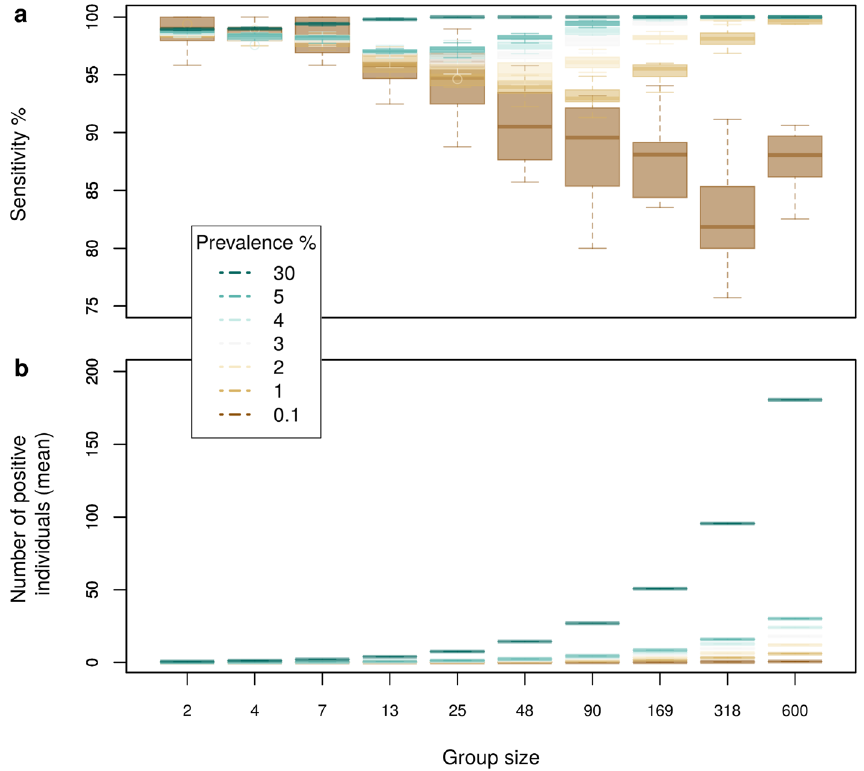
Figure 2. Effect of group size and prevalence on test sensitivity. Simulations were performed for seven prevalence scenarios and ten group sizes with 100 simulation iterations each. ( a ) The sensitivity of the test tends to decrease as the group size increases and this effect is greater, and has greater variability, at the lower prevalence tested. ( b ) In the higher prevalence tested, the sensitivity in larger groups is still high due to